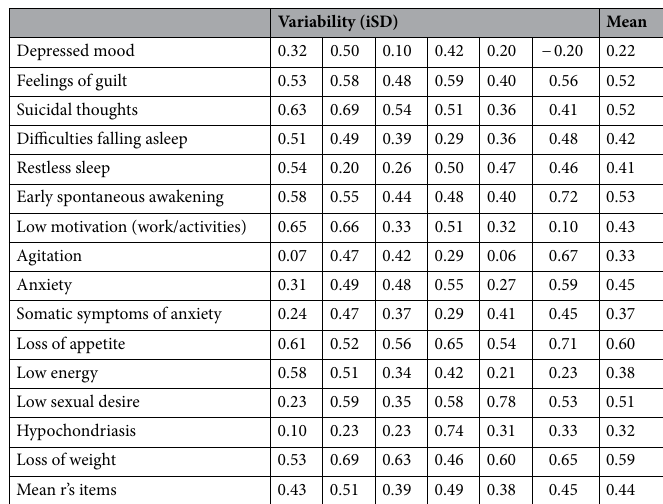
Table 6. Stability in individual levels of fluctuations (SD) over 4 weeks of the assessment period. N = 50 All correlations greater than 0.36 are significant at p < 0.05.